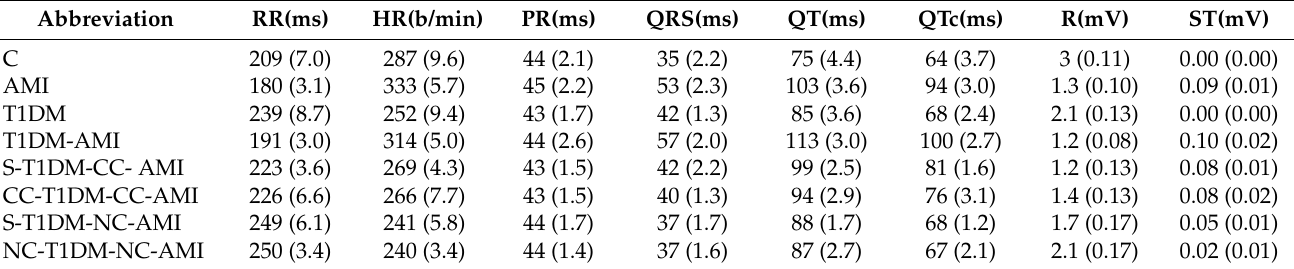
The values in the table represent the mean and standard deviation (in round brackets): HR—heart rate; C—control; AMI—acute myocardial infarction; T1DM—type 1 diabetes mellitus; S—saline (0.09%); CC—conventional curcumin solution (200 mg/Kg bw); NC—solution of curcumin nanoparticles (200 mg/Kg